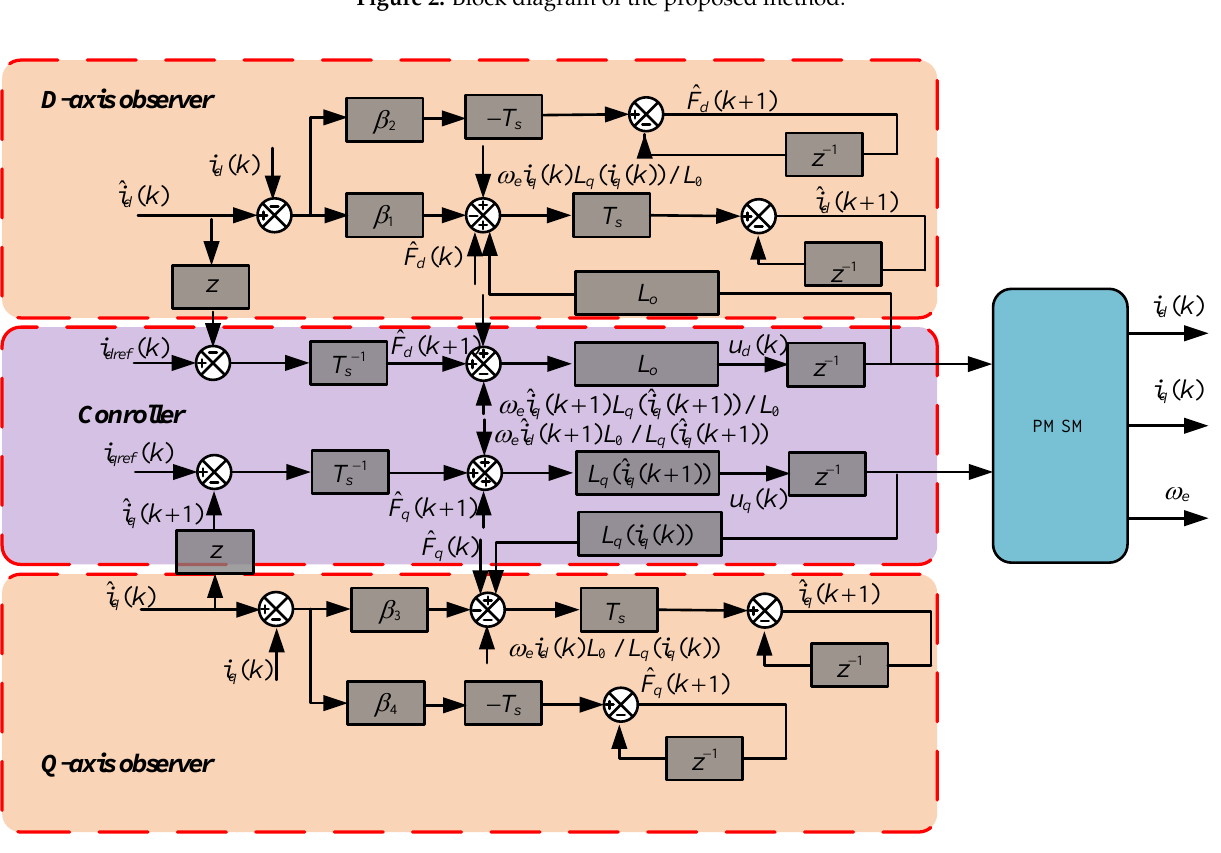
Figure 3. Block diagram of the FRRDBPCC.